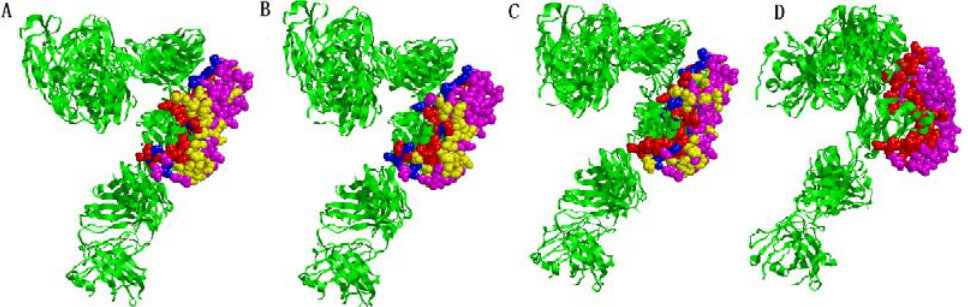
Figure 5. Predicted interface residues (red color) on protein (PDB: 1NFD_C) identified by (A) CA, (B) SVM (C) ME and (D) The actual interface residues. Red denotes true positive residues, blue denotes false negative residues, yellow denotes false positive residues, and pink denotes true negative